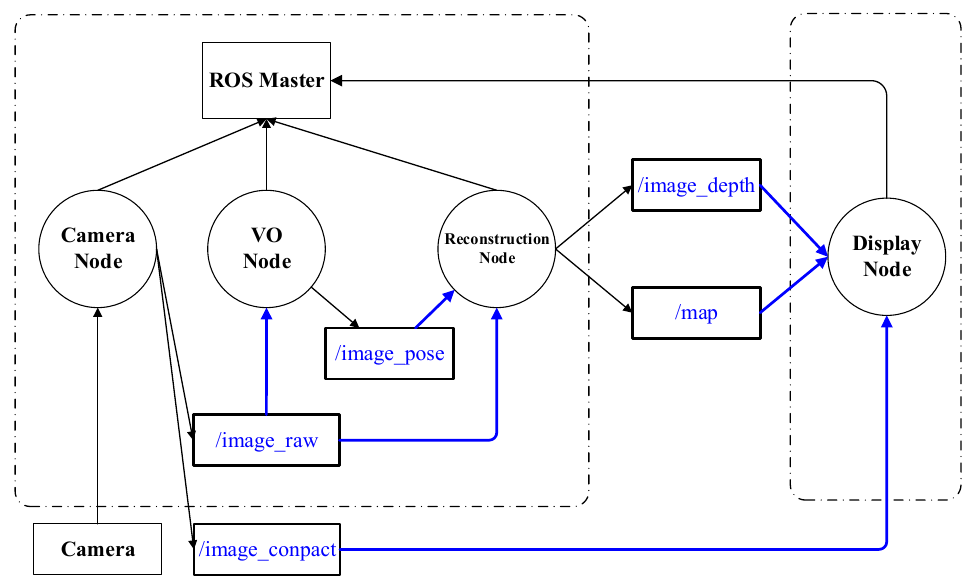
Figure 7. Topic communication design implemented in this study.